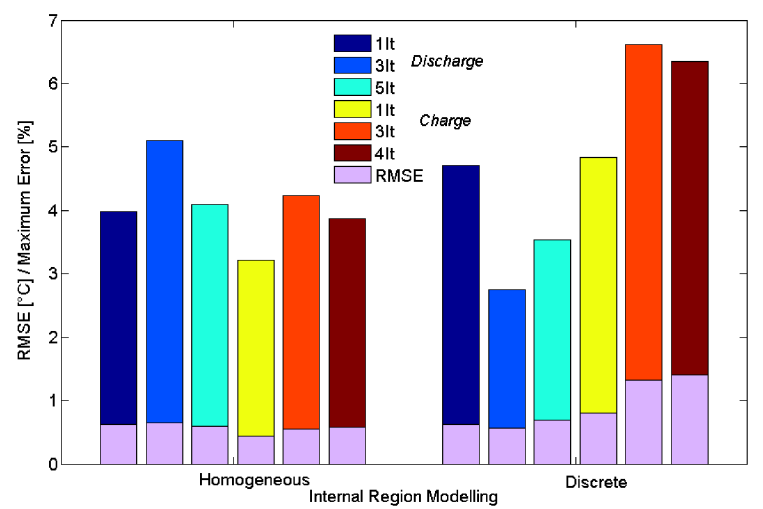
Figure 6. Root mean square and maximum temperature errors for both internal regions.